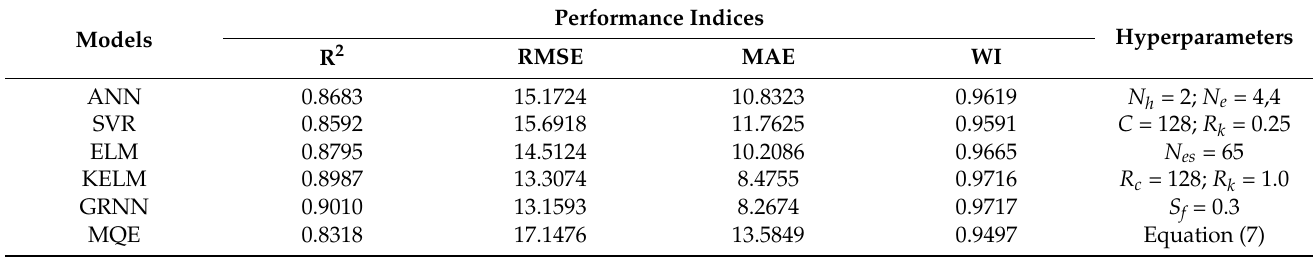
Table 5. Performance results of five common ML models using test